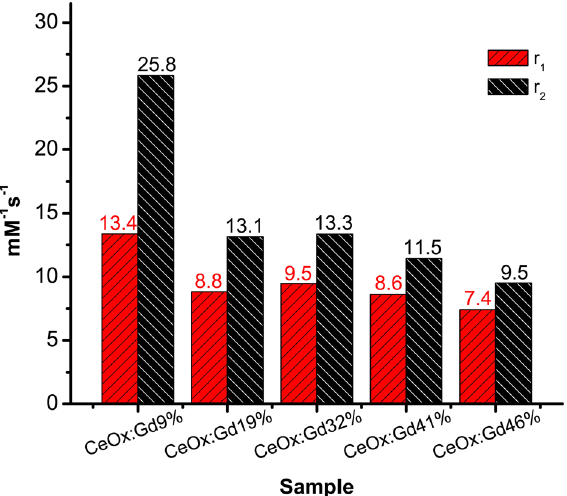
Figure 5. Relaxivities(r 1 and r 2 ) of CeOx:Gd:9%, CeOx:Gd:19%, CeOx:Gd32%, CeOx:Gd41% and CeOx:Gd46% are shown in the staple diagram Relaxivity plotted as a function of Gd (mM) for all five samples (9%, 19%, 32%, 41% and 46%) are presented in Supplementary